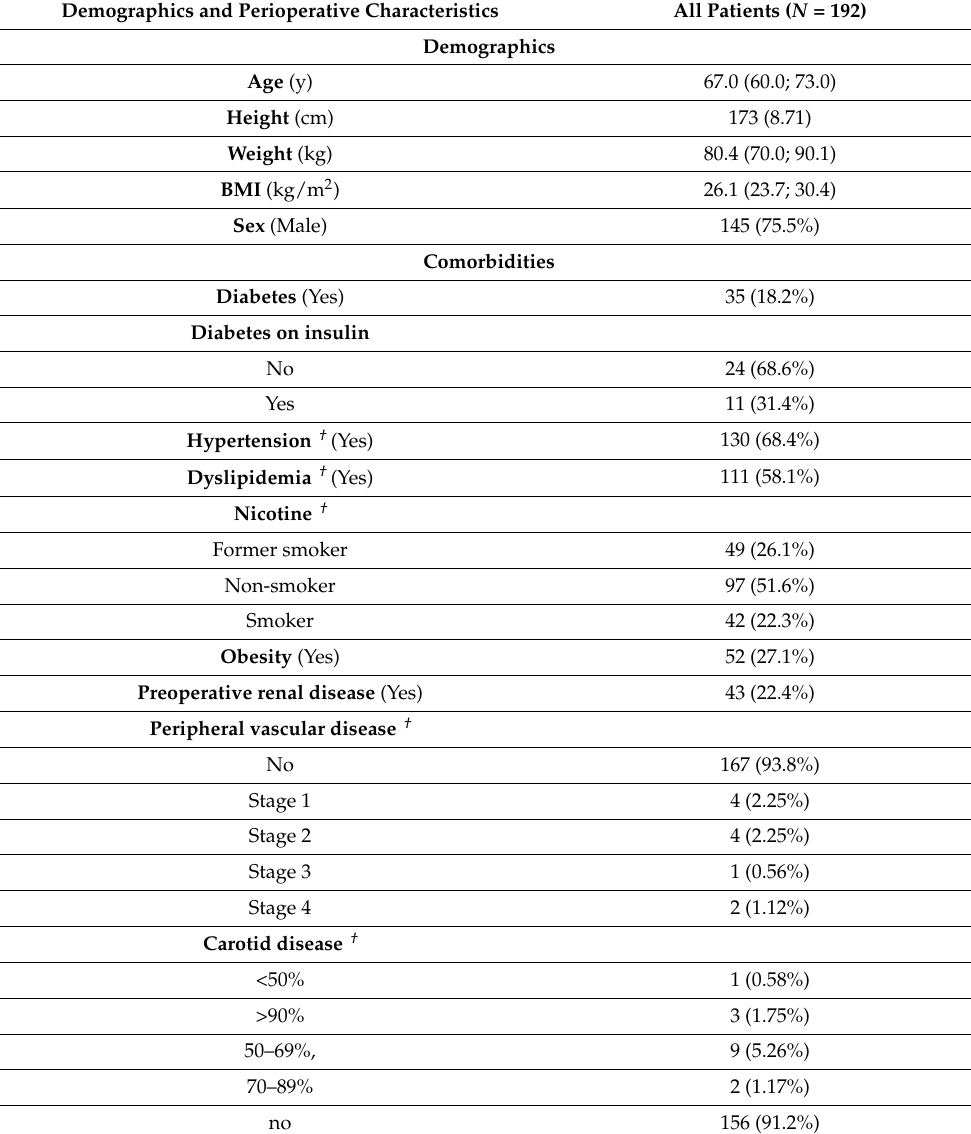
Table 1. Baseline patient demographics and perioperative